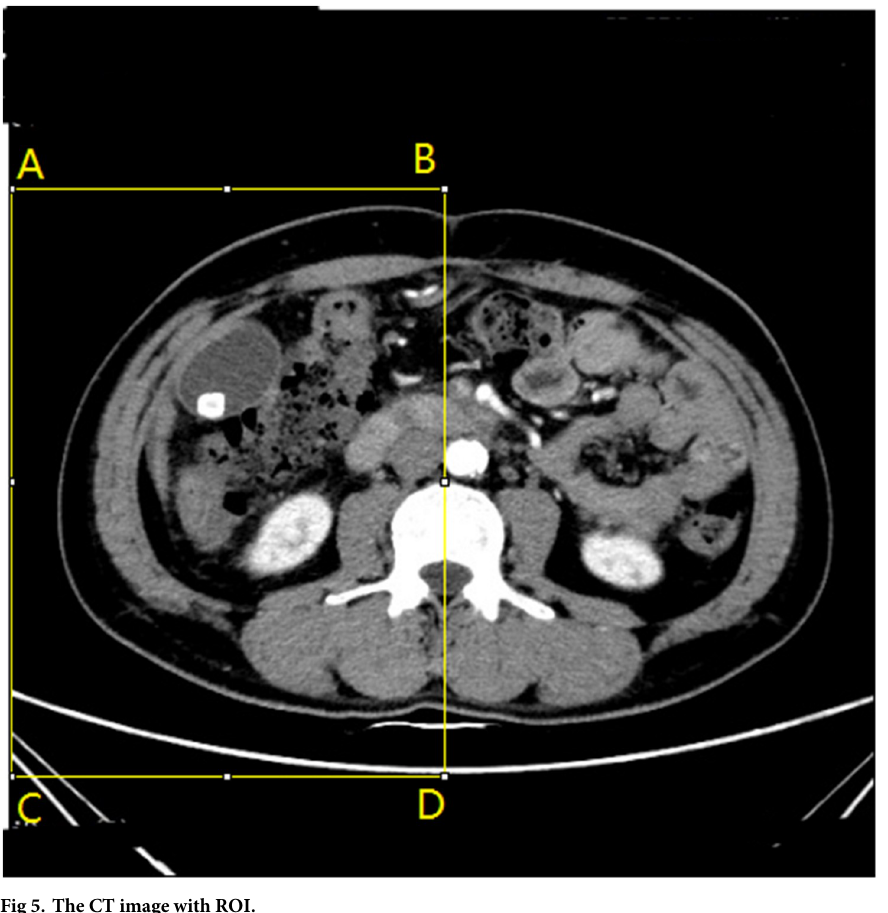
Fig 5. The CT image with